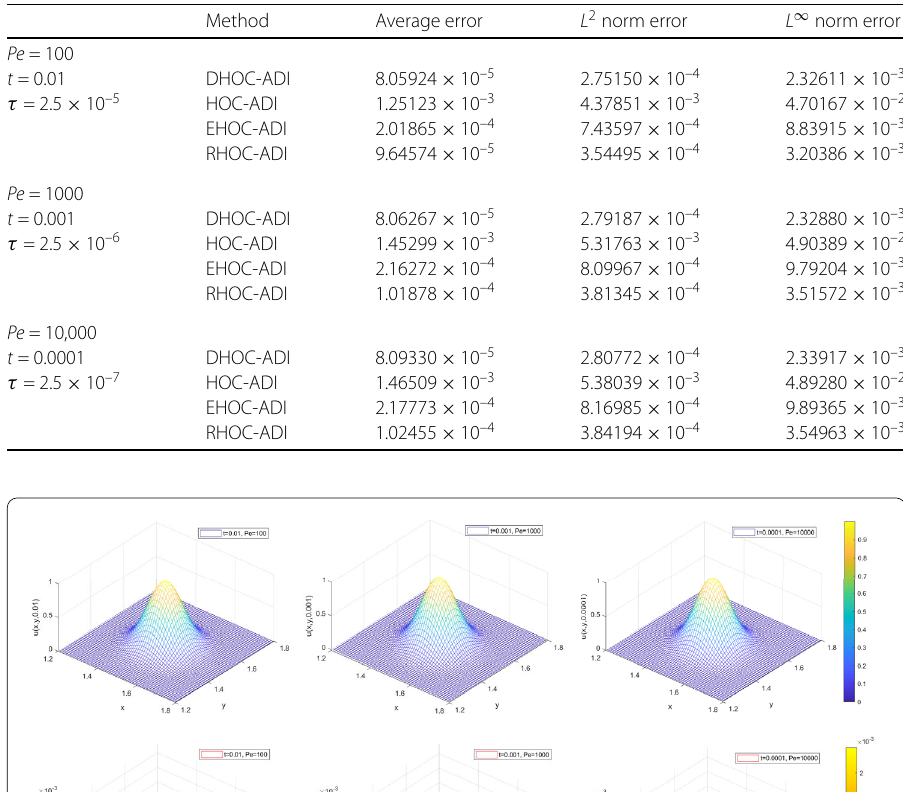
Table 8 Errors of numerical solutions using h x = h y = 0.01 with different Pe